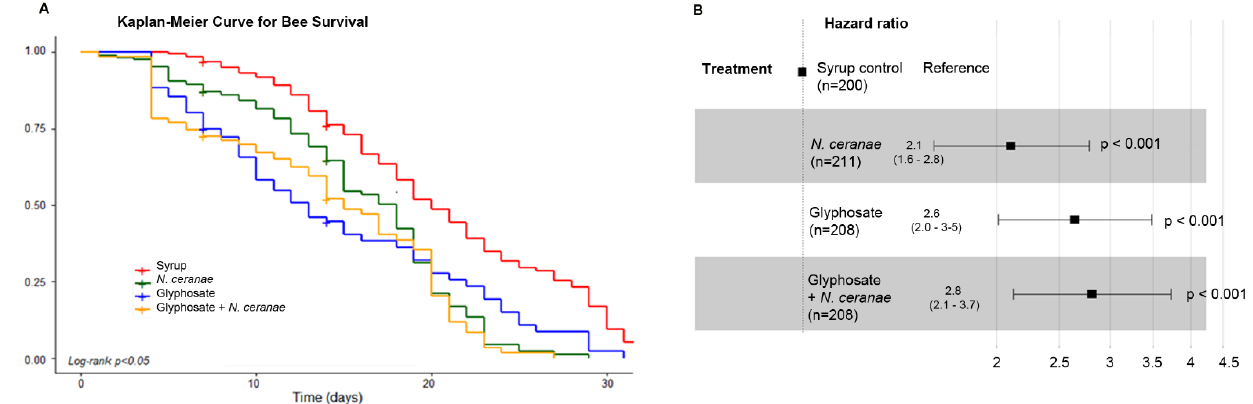
Figure 5. ( A ) Survival curve of honey bees subjected to chronic exposure to glyphosate (10 mg/L), N. ceranae (100,000 spores/bee at day 0) and both factors combined. In total, two hundred and ten bees per treatment were used (seventy bees per cage, three independent cages per treatment). ( B ) Hazard ratio of honey bees subjected to different stressors compared to the syrup control group